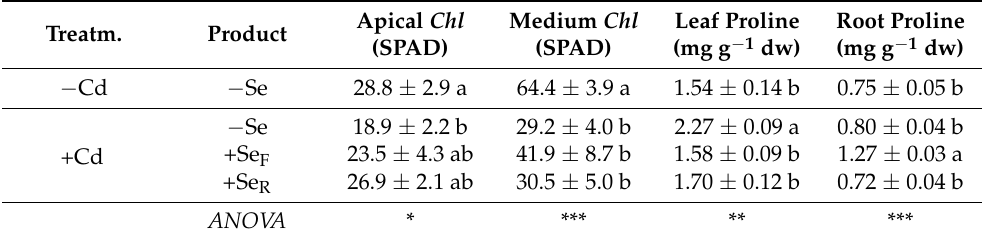
Table 1. Chlorophyll content in apical shoots (Apical) and fully expanded leaves (Medium), and proline in leaves and roots in pepper plants under four treatments of cadmium and selenium ( − Cd/ − Se, +Cd/ − Se; +Cd/+SeF and +Cd/+SeR). Treatm. Product